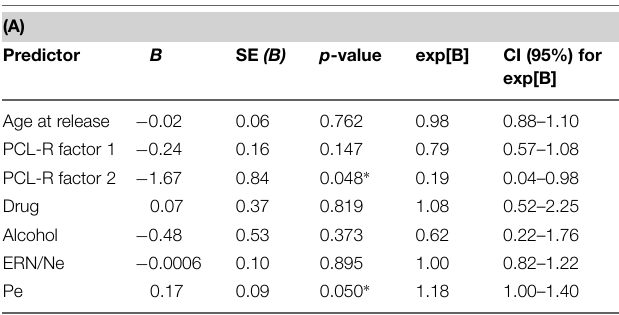
TABLE 6 | Logistic regressions combining ERP and fMRI with covariates predicting rearrest ( N = 45).